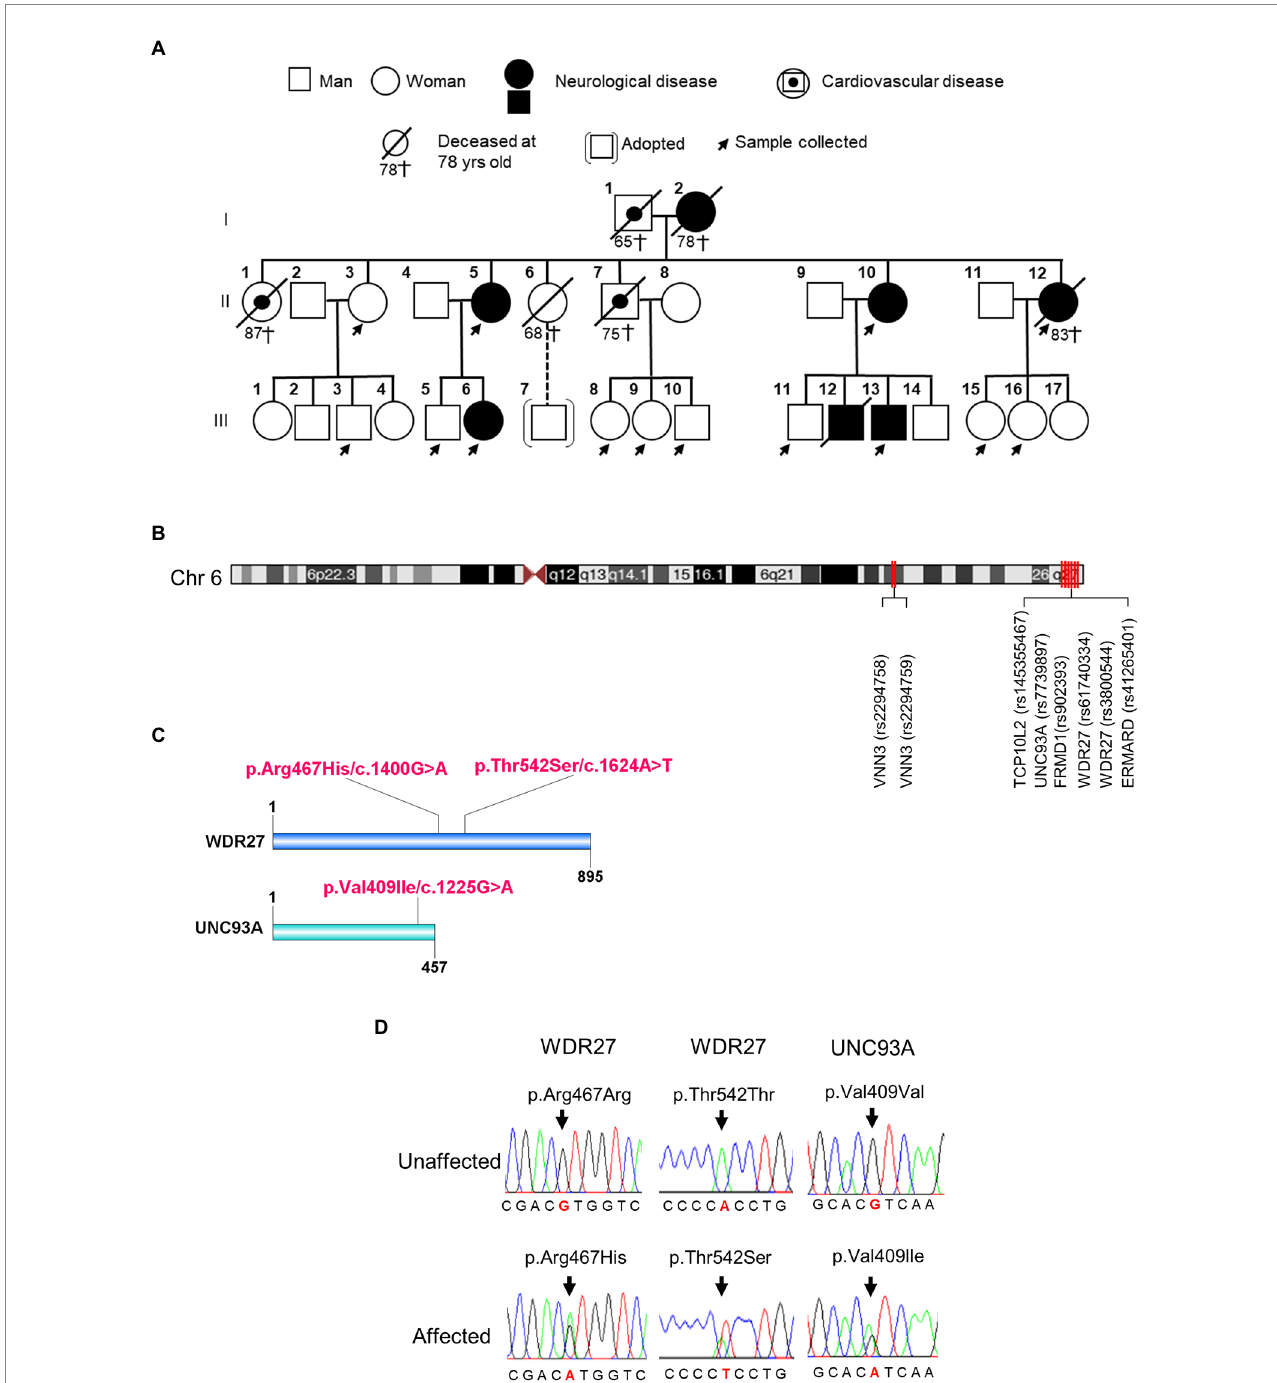
FIGURE 1 Family pedigrees and variants identified in affected members of family. (A) Pedigree of the Peruvian family. (B) The chromosomal position of UNC93A and WDR27 genes. (C) Location of a mutation in the protein structure. (D) An electropherogram from affected probands showing a base pair change in the UNC93A gene (Val409Ile/c.1225G > A) and in the WDR27 gene (Thr542Ser/c.1624A > T; Arg467His/c.1400G > A), compared to healthy